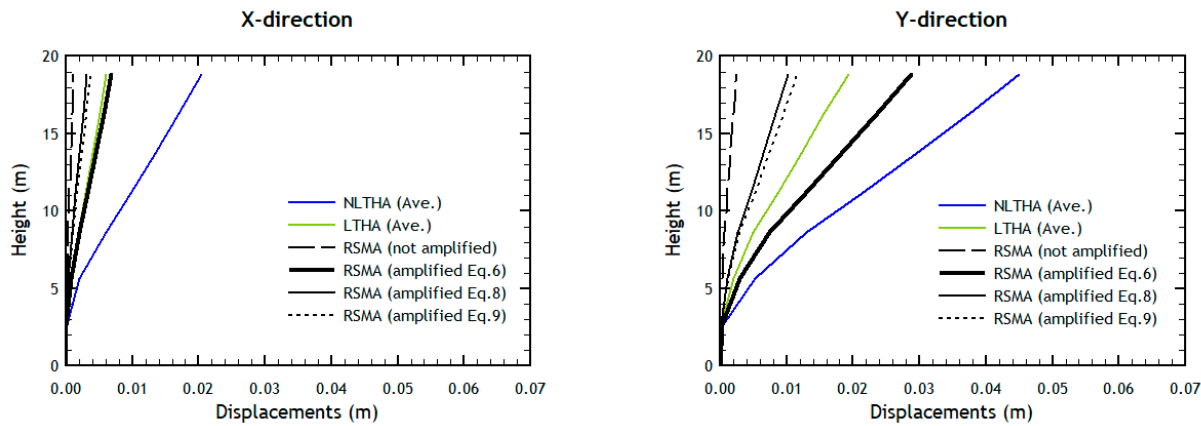
Figure 17. Maximum displacements as predicted by the different analyses.